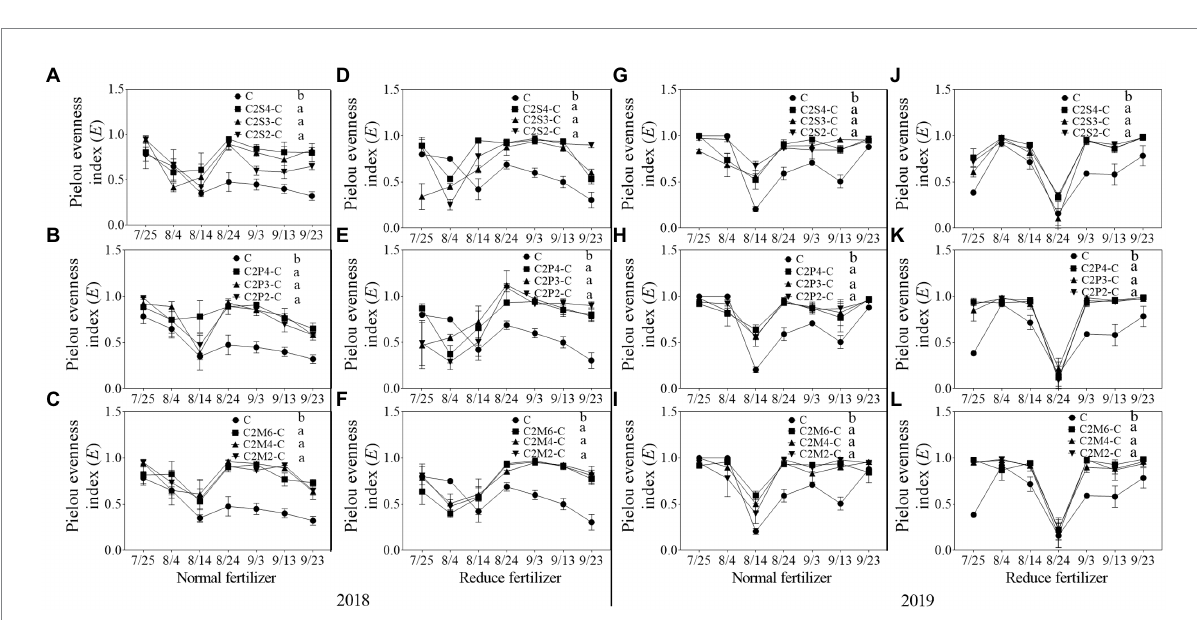
FIGURE 3 Pielou evenness index (E) of insect communities on corn plants intercropping with soybean, peanut, and millet under different planting patterns at normal and reduced fertilizer. A-C represent corn-soybean intercropping, corn-peanut intercropping and corn-millet intercropping under normal fertilizer in 2018, respectively. D-F represent corn- soybean intercropping, corn-peanut intercropping and corn-millet intercropping under fertilizer reduction in 2018, respectively. G-I represents corn-soybean intercropping, corn-peanut intercropping and corn-millet intercropping under normal fertilizer in 2019, respectively. J-L represent corn-soybean intercropping, corn- peanut intercropping and corn-millet intercropping under fertilizer reduction in 2019, respectively. C2S2-C, C2S3-C, C2S4-C: corn plants in the planting patterns of 2 corn rows intercropping with 2, 3, 4 rows of soybean; C2P2-C, C2P3-C, C2P4-C: corn plants in the planting patterns of 2 corn rows intercropping with 2, 3, 4 rows of peanut; C2M2-C, C2M4-C, C2M6-C: corn plants in the planting patterns of 2 corn rows intercropping with 2, 4, 6 rows of millet. Different lowercase represents a significantly different average of the 7 evaluations among different planting patterns at the same fertilizer level and the same intercropping type by the LSD test at p < 0.05,